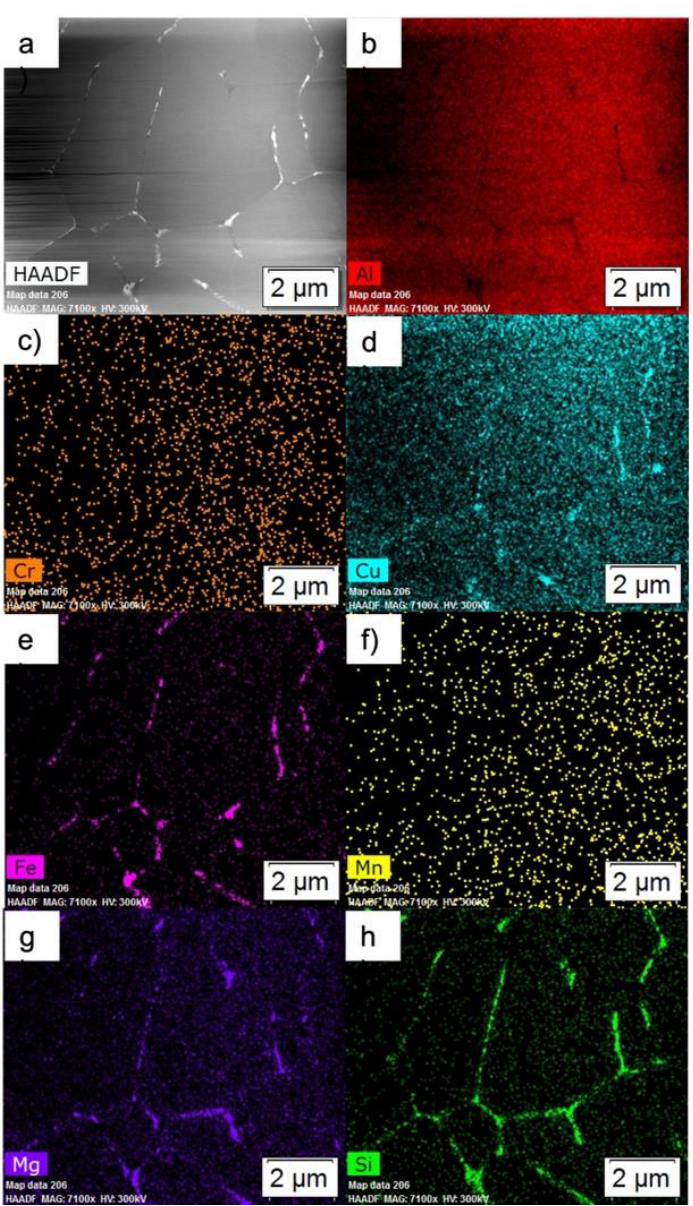
Figure 3. Overview images of the as-atomized powder: ( a ) HAADF, and EDS maps of ( b ) Al, ( c ) Cr, ( d ) Cu, ( e ) Fe, ( f ) Mn, ( g ) Mg, and ( h ) Si. High magnification of HAADF and EDS maps of a grain boundary in the as-atomized condition is shown in Figure 4. Note how the Fe-rich phases and Mg 2 Si are alternating on the boundaries, where the phases appear as stripes of alternating Fe-rich phases and Mg 2 Si. Figure 5 demonstrates a high magnification HAADF image of a triple point boundary in the as-atomized condition. Again, the Fe-rich phases and Mg 2 Si are alternating with one another. EDS here further indicates that the Fe-rich phase is an Fe-Si-Al